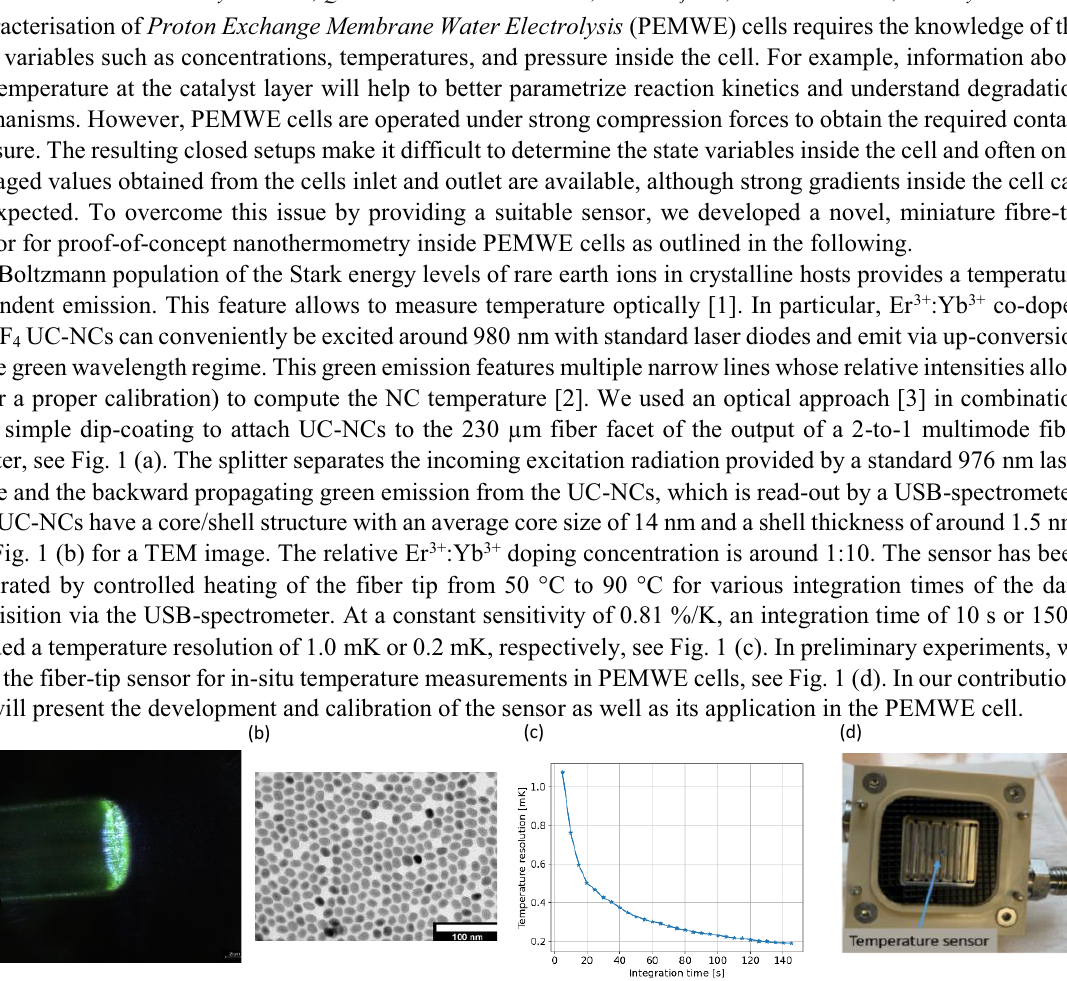
Fig. 1 (a): Microscopy image of the fiber-tip (diameter: 230 µm) with attached UC-NCs and their characteristic green emission. (b): TEM image of the used UC-NCs with an average core size of 14nm. (c): Absolute temperature resolution of the sensor in dependency of the integration time. (d): PEMWE with drilled entrance hole for the fiber-tip